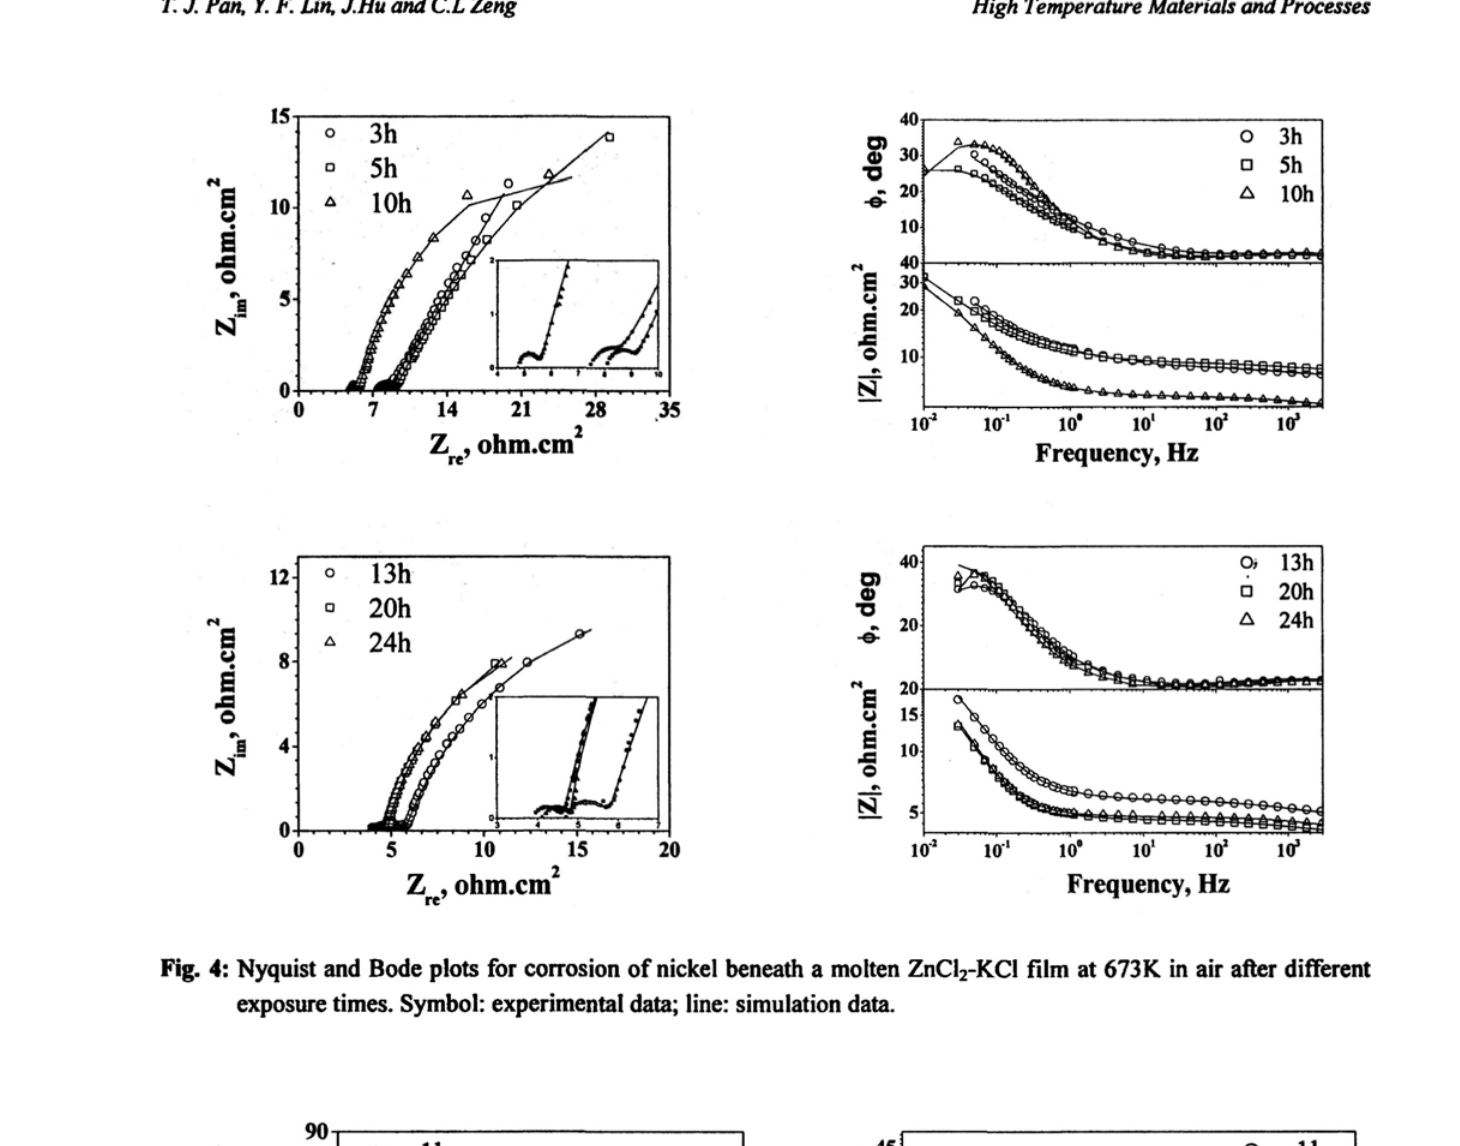
Fig. 4: Nyquist and Bode plots for corrosion of nickel beneath a molten ZnCI exposure times. Symbol: experimental data; line: simulation data.